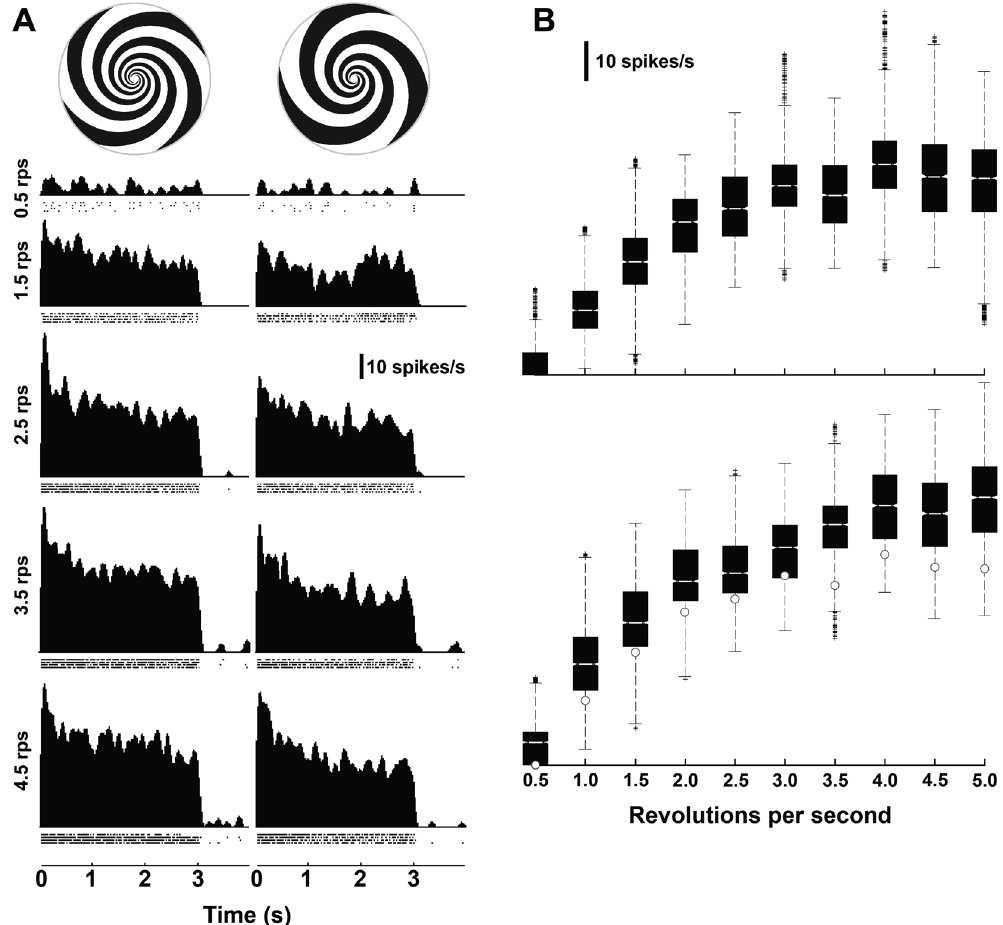
Figure 5. Speed tuning of DNIII neurons to frontal stimulation. ( A ) Spike density functions of a DNIII 2 neuron to 2 different expanding spirals at different rotation speeds (4-arm spiral: left panel; 3-arm spiral: right panel). The stimulus ran from 0 to 3 s. ( B ) Box plots showing the median responses from recordings obtained from 8 DNIII neurons (including the cell in A) using two different spirals. On each box, the central mark is the median, the edges of the boxes are the 25th and 75th percentiles, the whiskers extend to the most extreme data points not considered outliers, and outliers are plotted individually (crosses). The upper panel is the 3-arm spiral and the lower the 4-arm spiral. The white dots in the lower plot show the medians for the 3-arm spiral. Abbreviations: rps: revolutions per